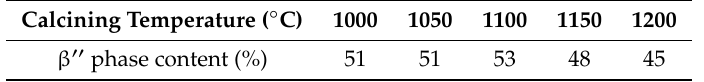
Figure 3. XRD spectra of the precursor powders at different calcining temperatures ( a ) 950–1200 °C ; ( b ) 700–900 °C. Table 1. The β ”-Al 2 O 3 phase contents of the precursor powders at different calcining temperatures.